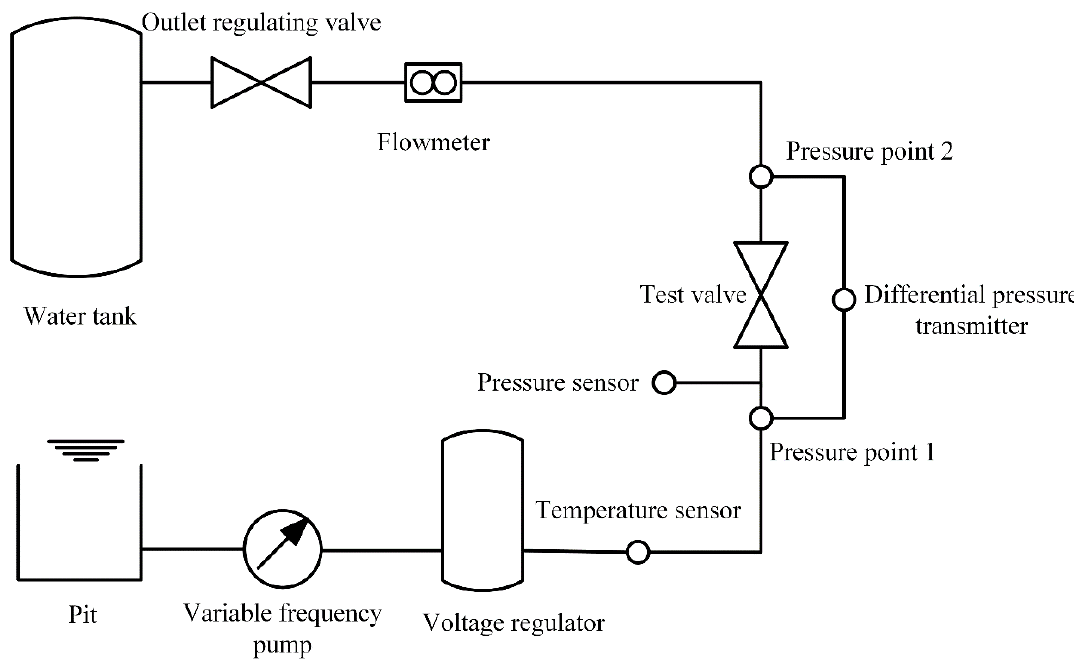
Figure 5. Layout of the experimental circuit.